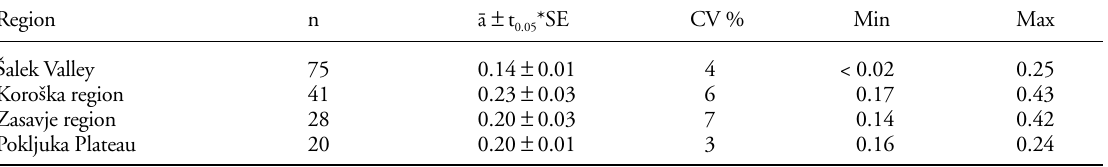
Table 4. Levels of As (mg kg –1 wet weight) in kidneys of roe deer shot in some Slovenian regions in 1997. The arithmetic means ( ā ) with the 95% confidence intervals, coefficient of variation (CV %) and range (Min, Max) are given. Region